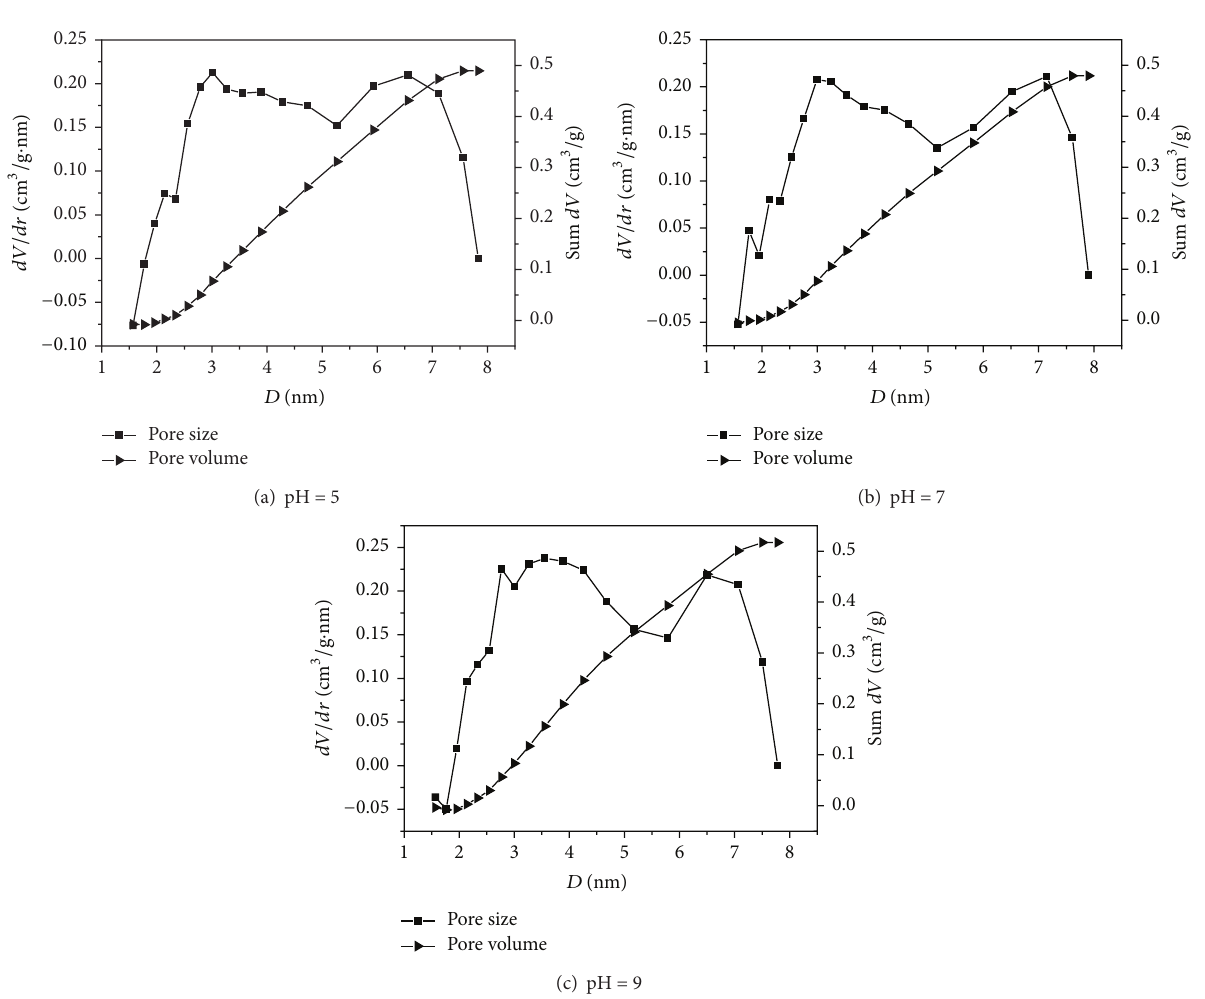
Figure 4: The pore volume and pore size of the modified clay containing SSA.